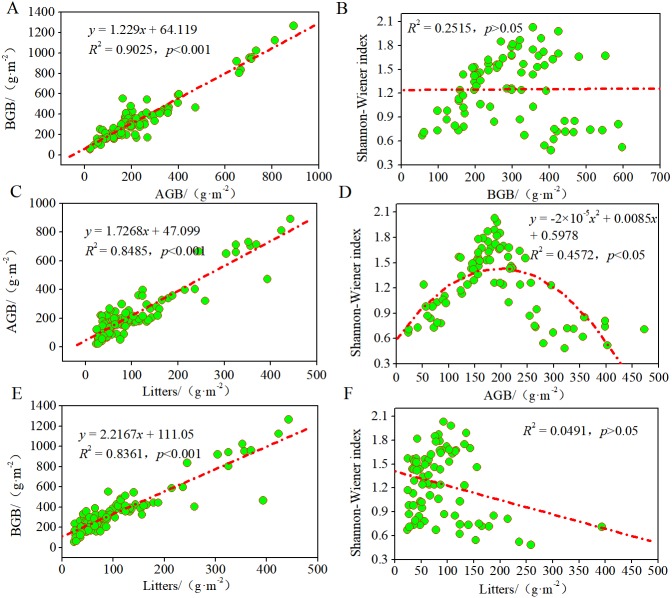
Relationships among litters, biomass and the Shannon–Wiener index of plant communities.Regression relationship equations were established (n = 90), and the model confidence intervals were 95% and 99% (p < 0.05 and p < 0.1). (A) regression relationship between AGB and BGB; (B) regression relationship between BGB and Shannon–Wiener index; (C) regression relationship between AGB and litters; (D) regression relationship between Shannon–Wiener index and AGB; (E) regression relationship between BGB and litters; (F) regression relationship between Shannon–Wiener index and litters.